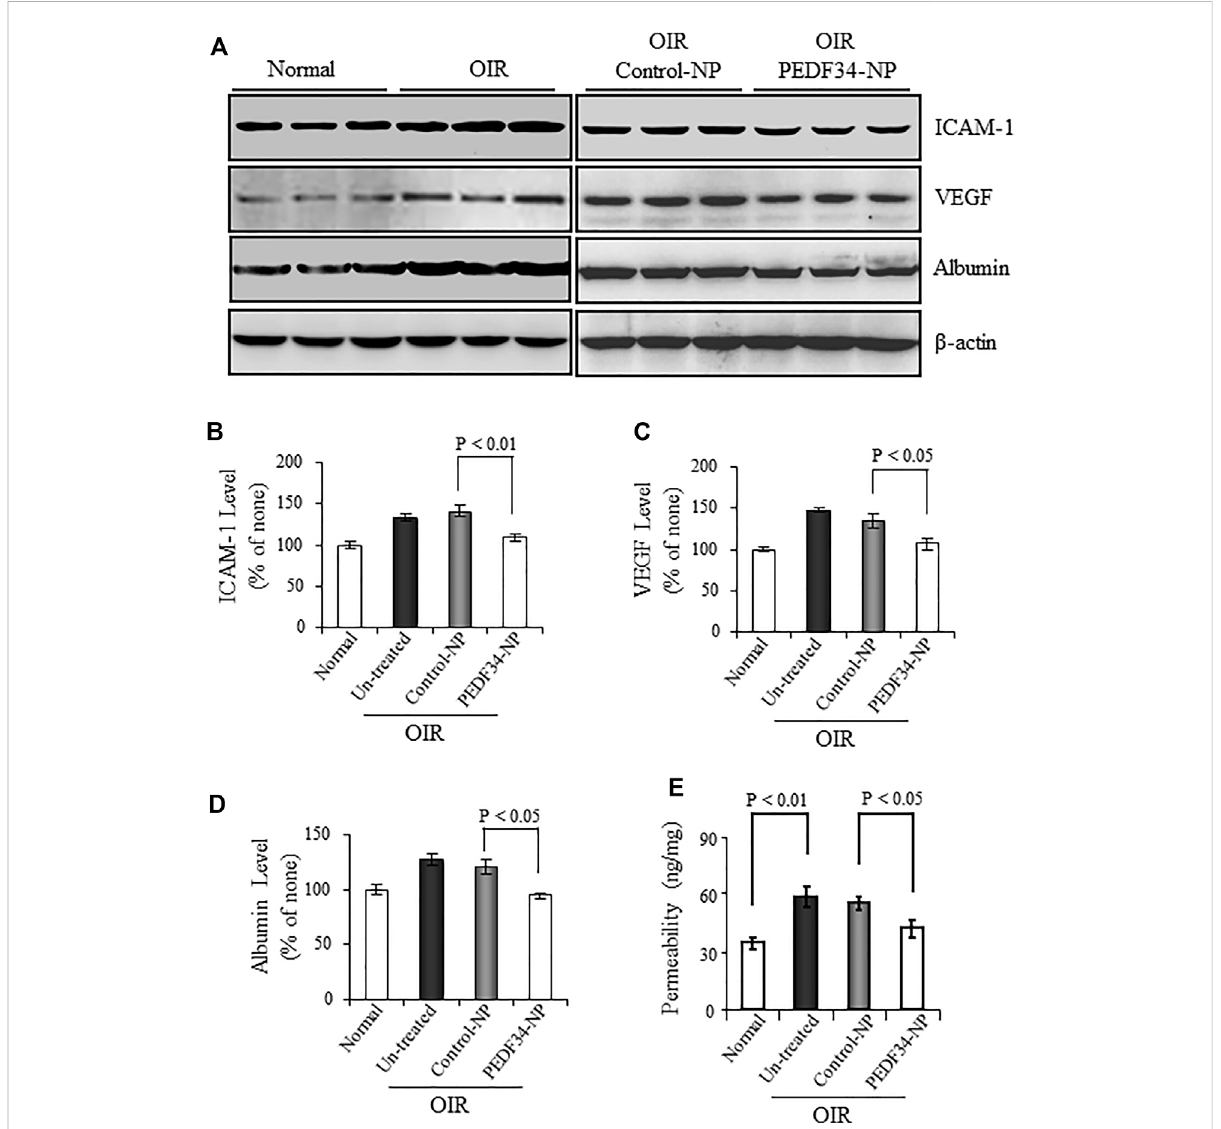
FIGURE 3 EffectofPEDF34-NPonretinalin fl ammatoryfactorexpressionandvascularleakageinOIRrats.OIRratsreceivedanintravitrealinjectionof5 µg PEDF34-NP or Control-NP. (A) At P16 the retina was perfused, and retinal levels of ICAM-1, VEGF, and albumin were determined by western blot analysis, with β -actin as loading control. (B – D) Retinal levels of ICAM-1, VEGF, and albumin were quanti fi ed by densitometry and expressed as % of thatinnormalratretinas(mean±SD, n =3). (E) RetinalvascularpermeabilitywasmeasuredusingtheEvansblueastraceratP16,andnormalized by the total retinal protein concentration (mean ± SD, n =